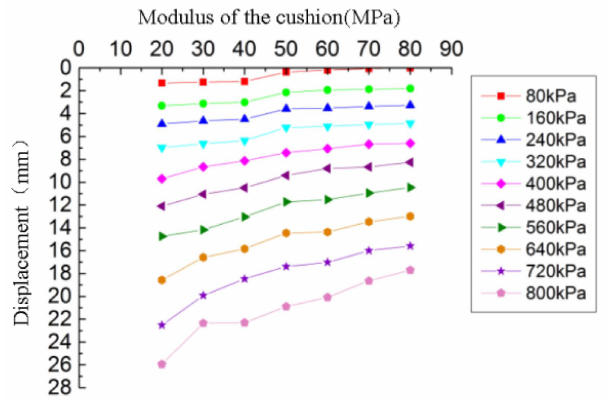
Figure 20. The elastic modulus of the cushion e ff ect on the curve of settlement.